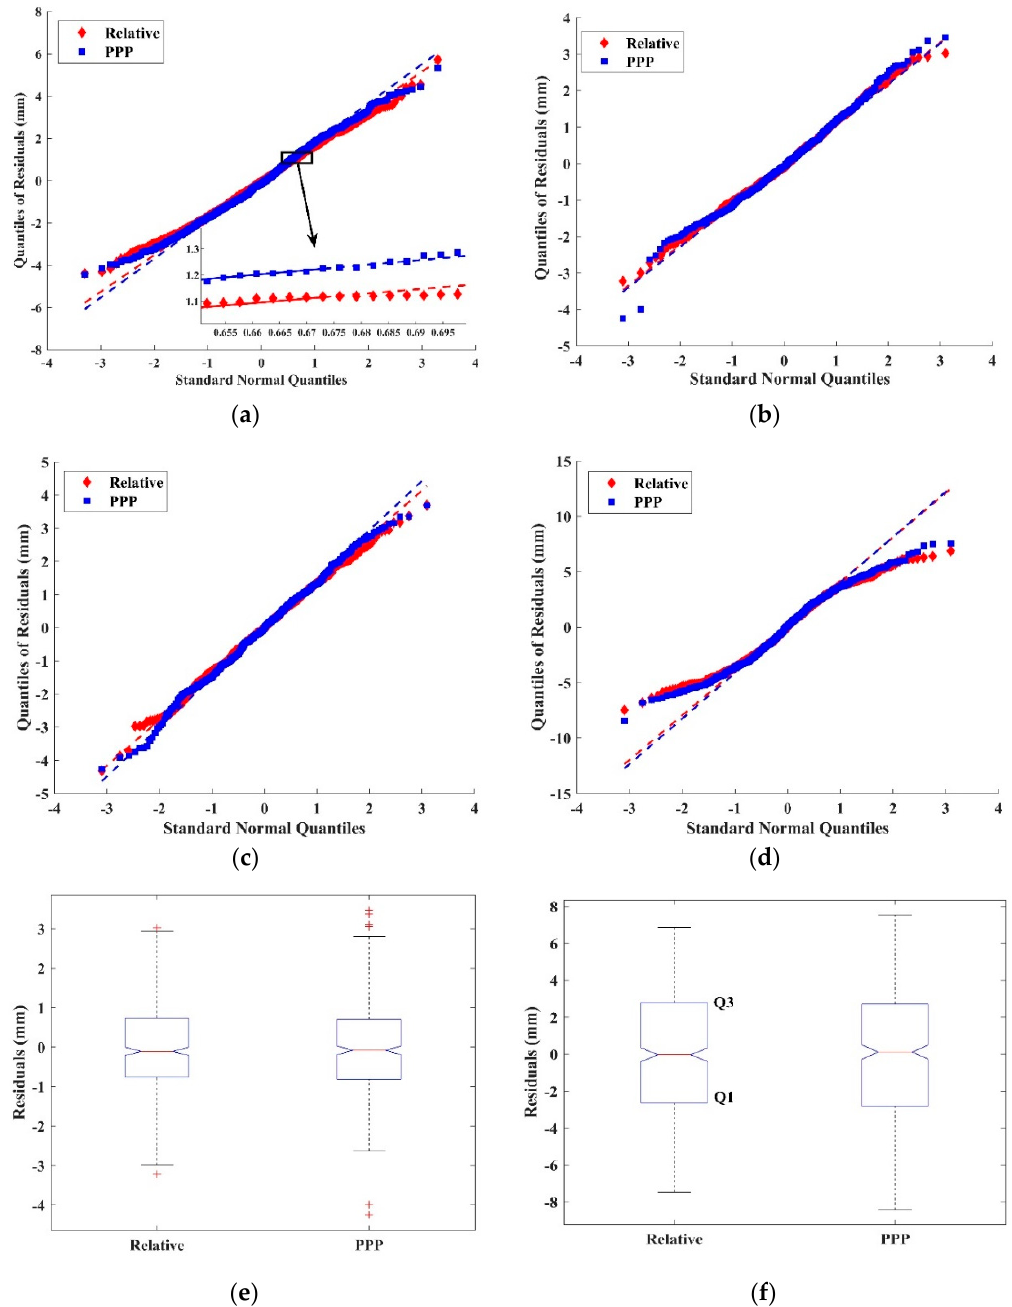
Figure 12. Residual Q-Q plot of events 1 ( a ), 2( b ), 3 ( c ), and 4 ( d ) and box-plots of events 2 ( e ) and 4 ( f ). Table 3. Statistical results of GNSS residuals.